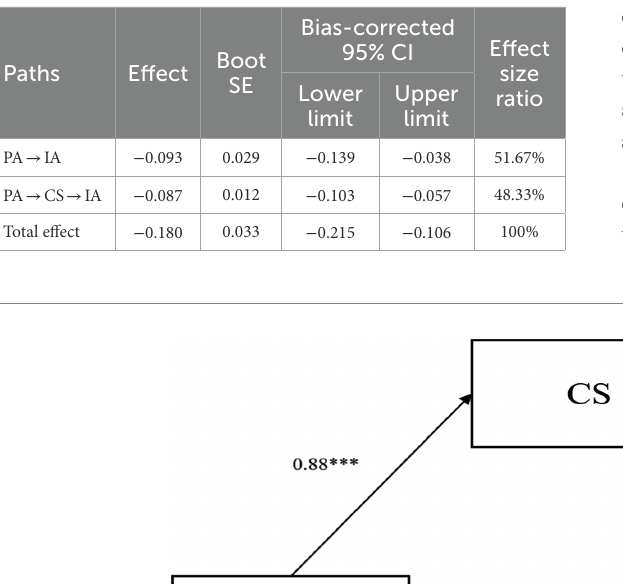
TABLE 6 Bootstrap analysis of the mediating effect test.